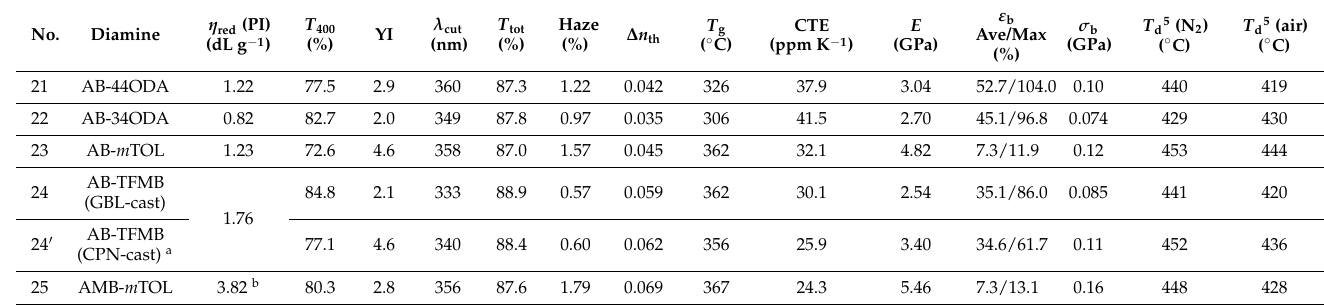
Table 4. Film properties of H-PMDA-based PIs obtained using bisamide-type